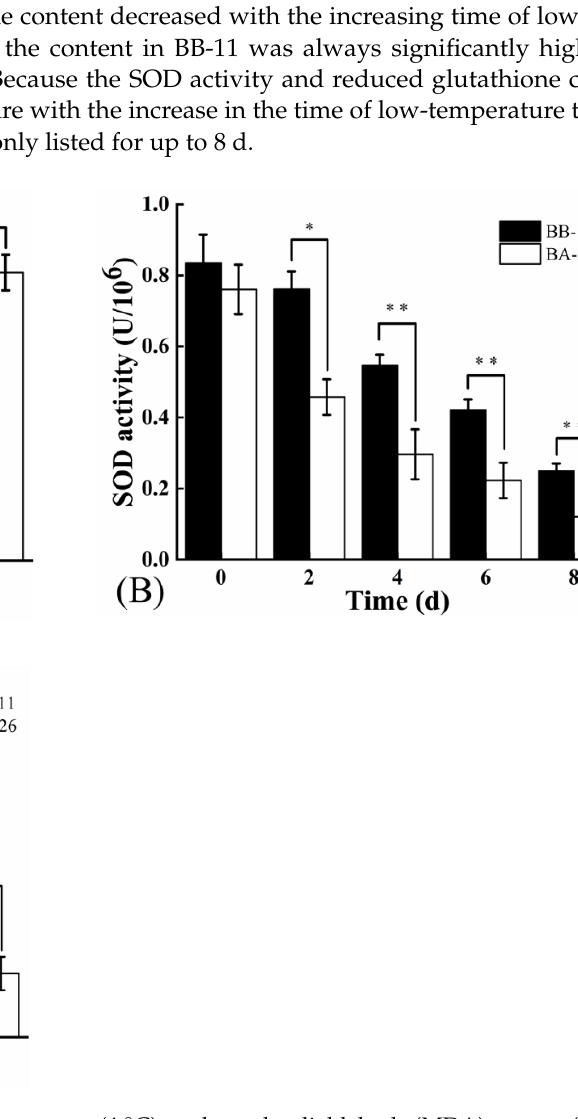
Figure 2. Effect of low temperature (4 °C) on the malondialdehyde (MDA) content ( A ), superoxide dismutase activity (SOD) ( B ) and reduced glutathione (GSH) content ( C ) in S. aureus. Error bars represent standard deviations ( n = 3) (* p < 0.05, ** p < 0.01, and *** p < 0.001).